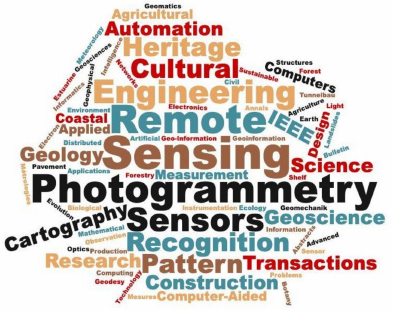
Figure 1. Word cloud from the 4 databases obtained using the search terms “3D Laser Scanning” + “3D Point